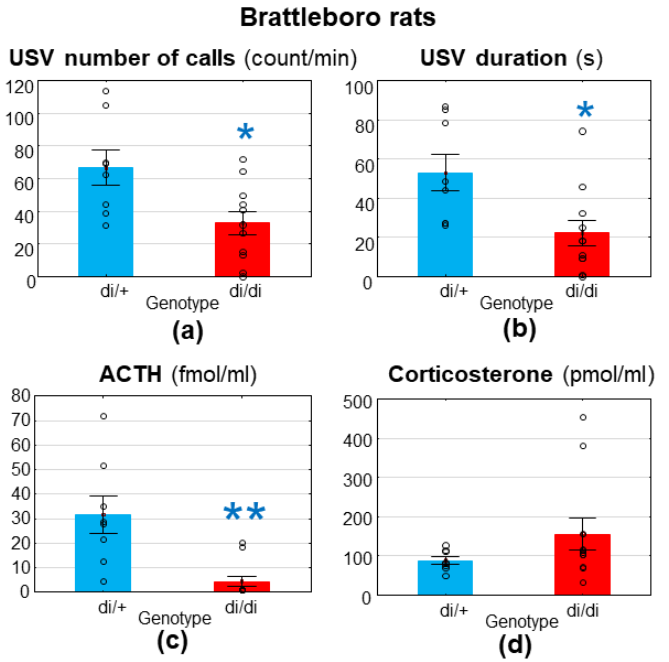
Figure 1. Brattleboro rats. The 7–8-day-old pups emitted reduced ultrasonic vocalization to maternal separation, measured for 10 min both in terms of ( a ) the number of calls (count/min) and ( b ) the duration (s) 30 min after a single intraperitoneal saline injection. Moreover, they showed reduced ( c ) adrenocorticotropin (ACTH, fmol/mL) elevation at the end of separation without significant changes in ( d ) corticosterone (pmol/mL) levels. di/+ = heterozygous; di/di = homozygous diabetes insipidus pups, without functional vasopressin; n = 8–11. * p < 0.05. ** p < 0.01 vs. di/+ control.